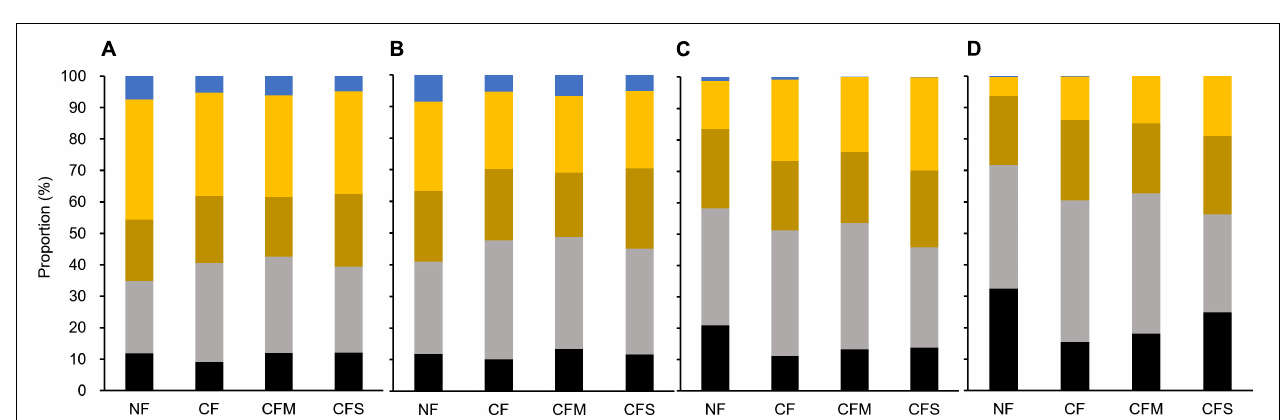
FIGURE 5 | Gene abundance of fungi ( A , 10 7 copies g − 1 SOC) and bacterial (embedded in A , 10 9 copies g − 1 SOC) in different-size fractions and proportion (%) possessed by macroaggregates > 250 µ m (B) , of water-stable aggregates of the rice paddy.